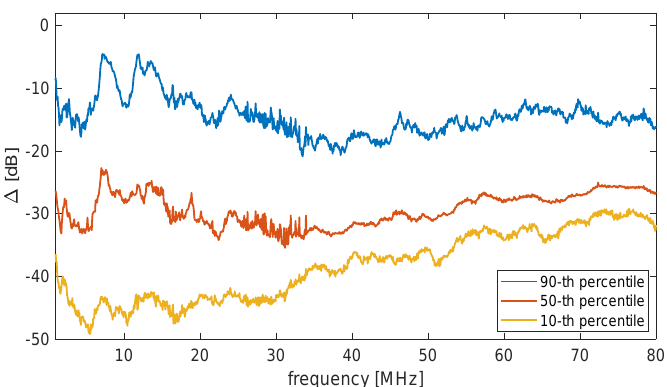
Figure 10. Statistical distribution of ∆ in the dB scale for different